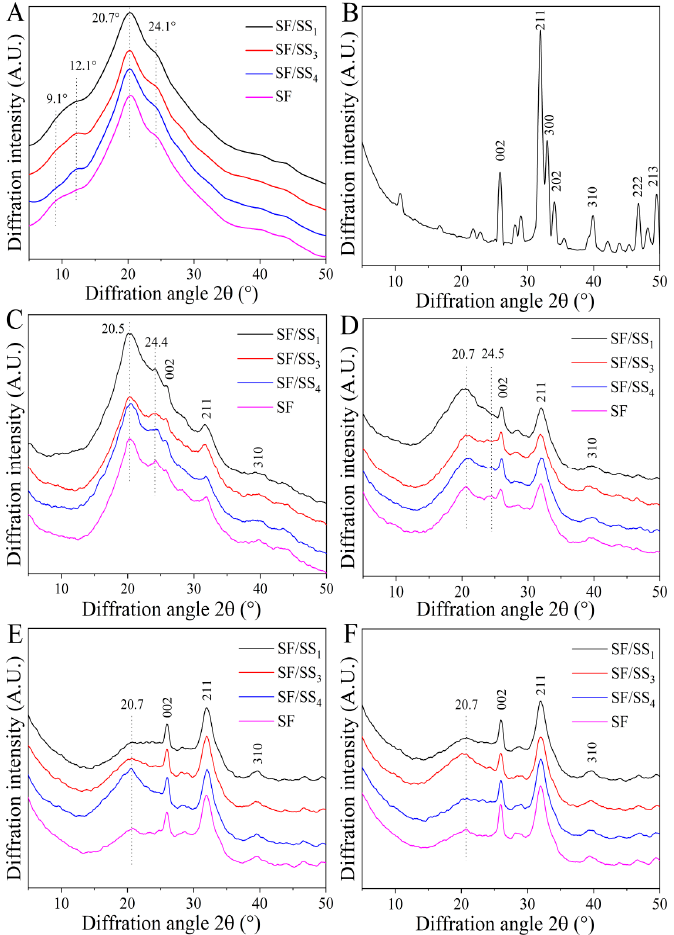
Figure 10. XRD patterns of the mineralized SF/SS composite films and pure HAp. ( A ) Unmineral- ized, ( B ) HAp, ( C ) 1 d, ( D ) 3 d, ( E ) 5 d, ( F ) 7 d.